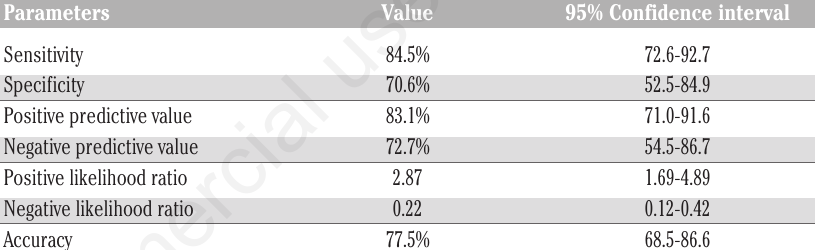
Table 3. Diagnostic accuracy of diagnosis of NTDT by RDW ≥ 21.0% in the validation